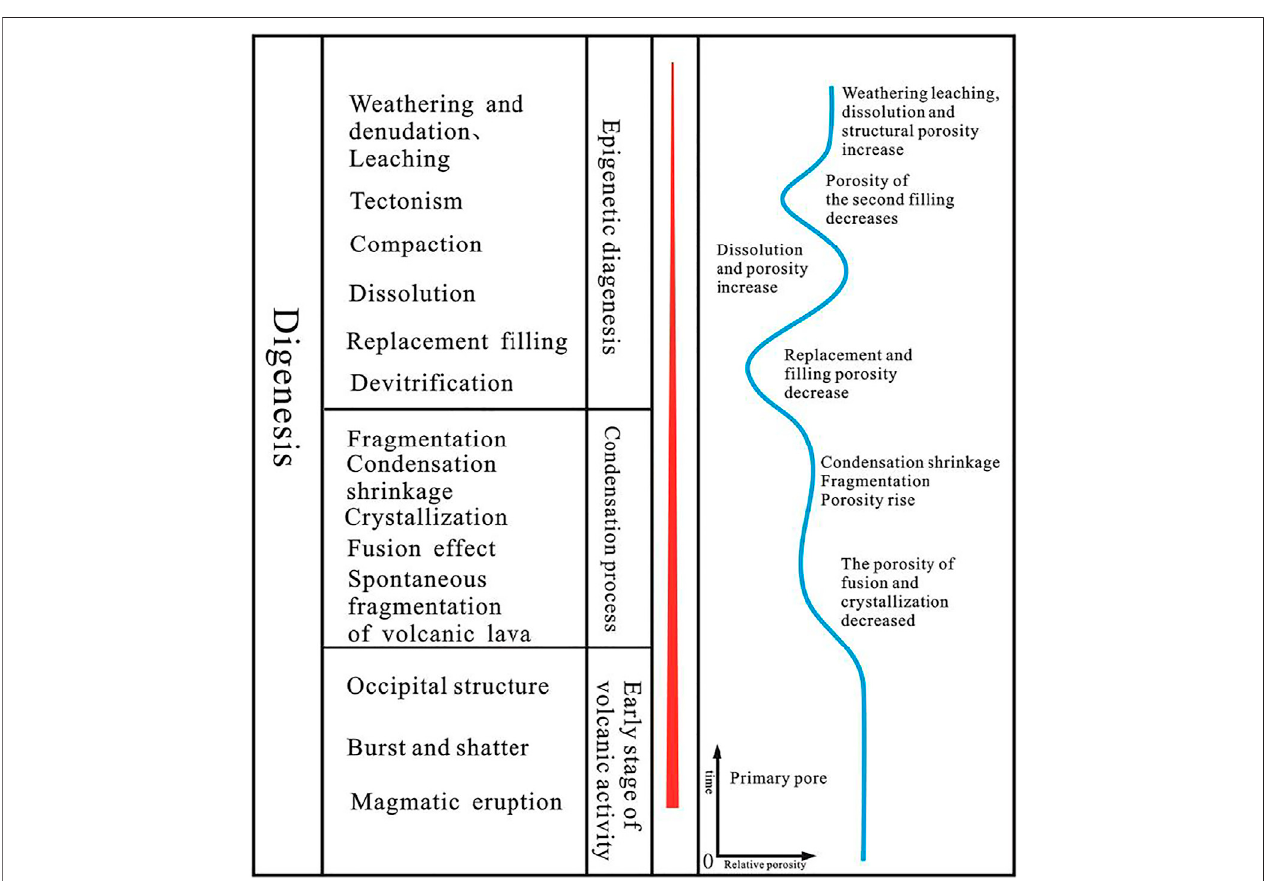
FIGURE 11 | Diagenesis and porosity evolution of volcanic reservoir in the D oil fi eld of the Laizhouwan sag.